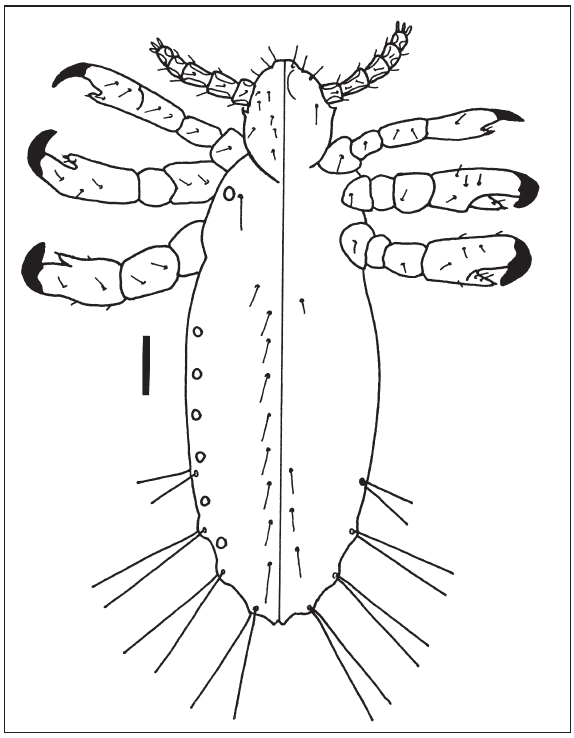
Linognathus weisseri , n. sp., first instar nymph. Dorso- ventral view. Scale bar = 0.1